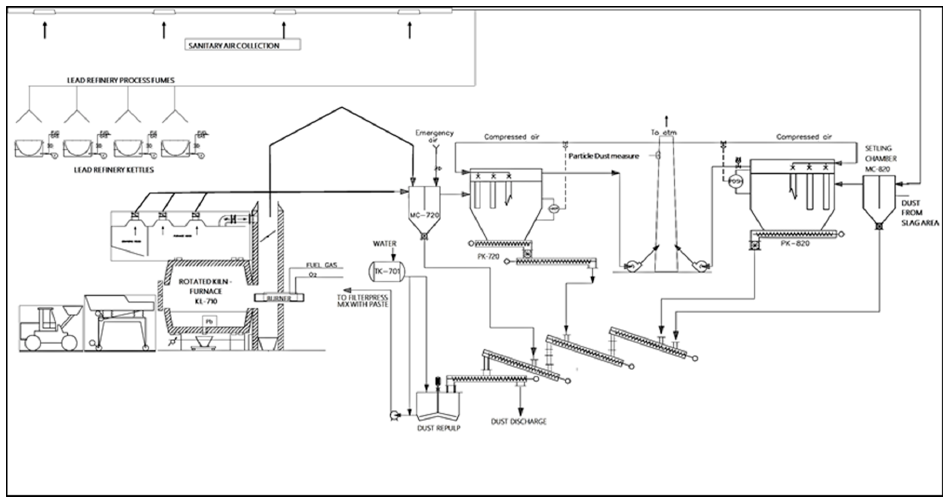
Figure 1. Sunlight air-pollution control system.